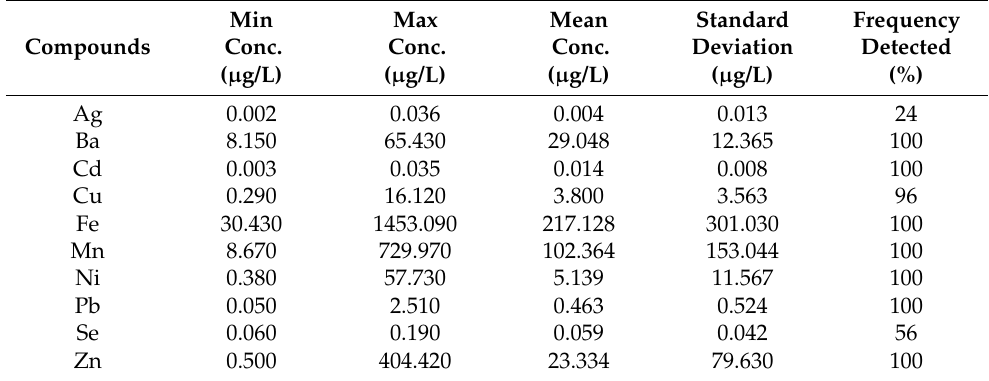
Table 1. Statistical summary of target trace element concentration in the Han River watershed. Compounds